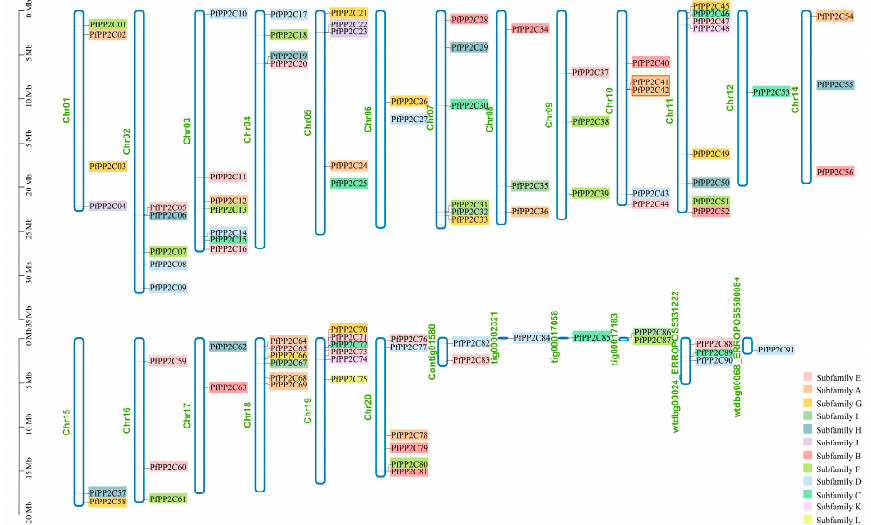
Figure 2. Chromosome mapping of PP2C family members in P. fortunei.